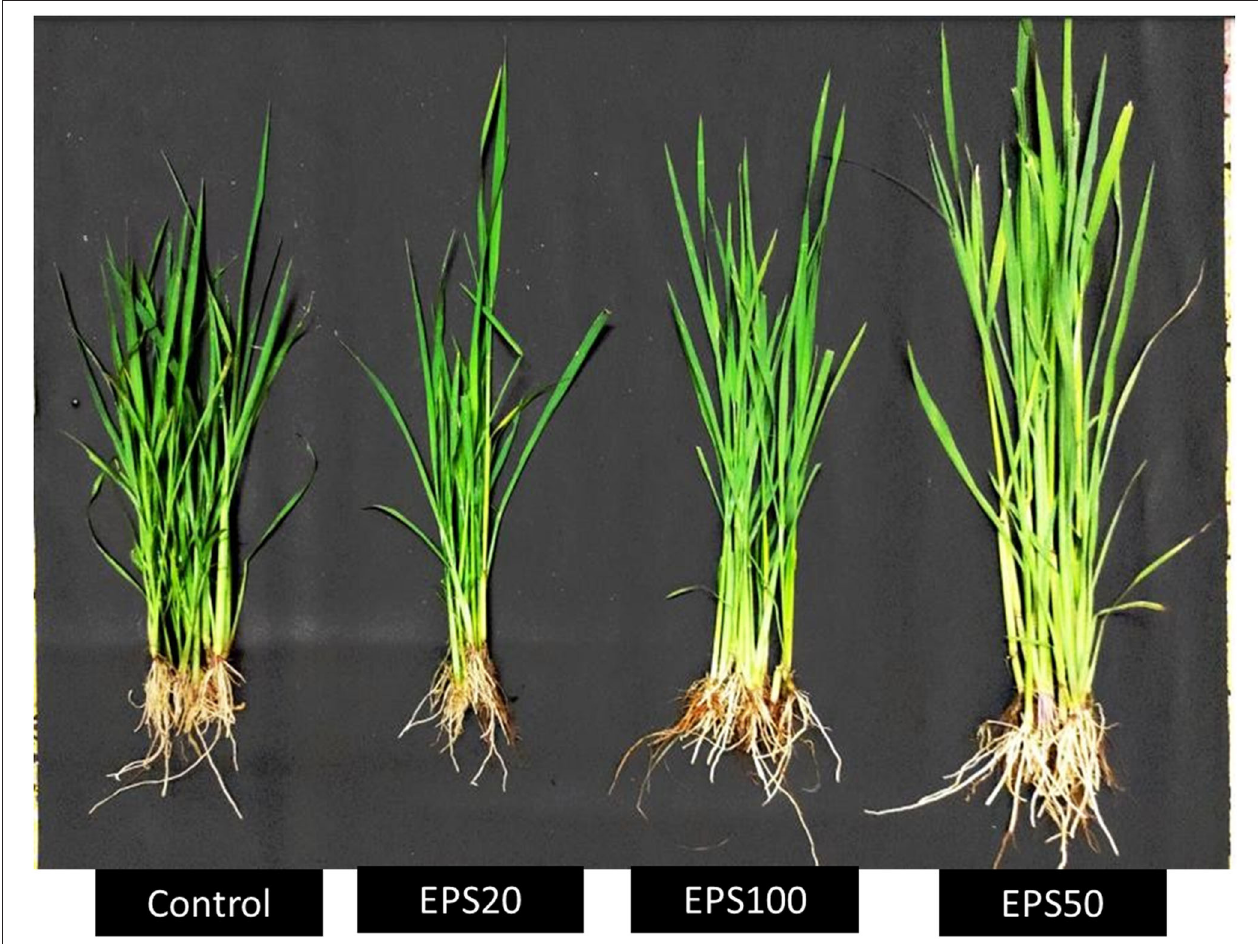
FIGURE 4 | Phenotypes of rice seedlings Oryza sativa ssp. indica MTU 7093 Swarna under drought stress (induced by PEG treatment) sprayed with 20, 50, and 100 ppm EPS of C . alatae LCS1 endophyte.